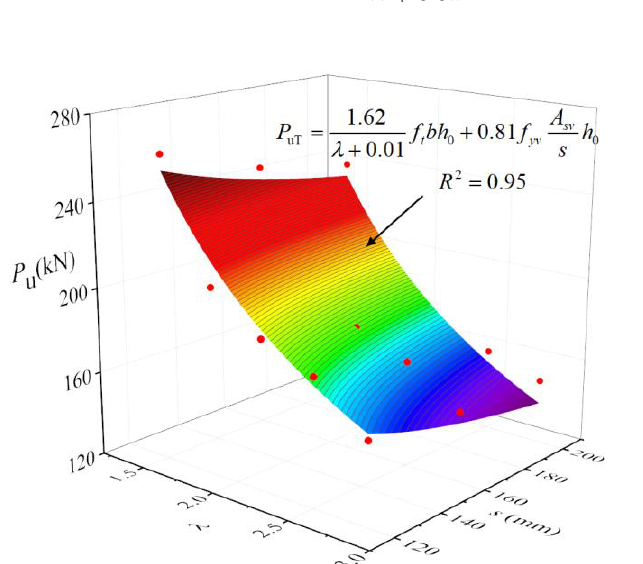
Figure 18. Three-dimensional relationship between P u , λ , and s . Therefore, the shear bearing capacity of the indirectly loaded beam after fire exposure is calculated using Equation